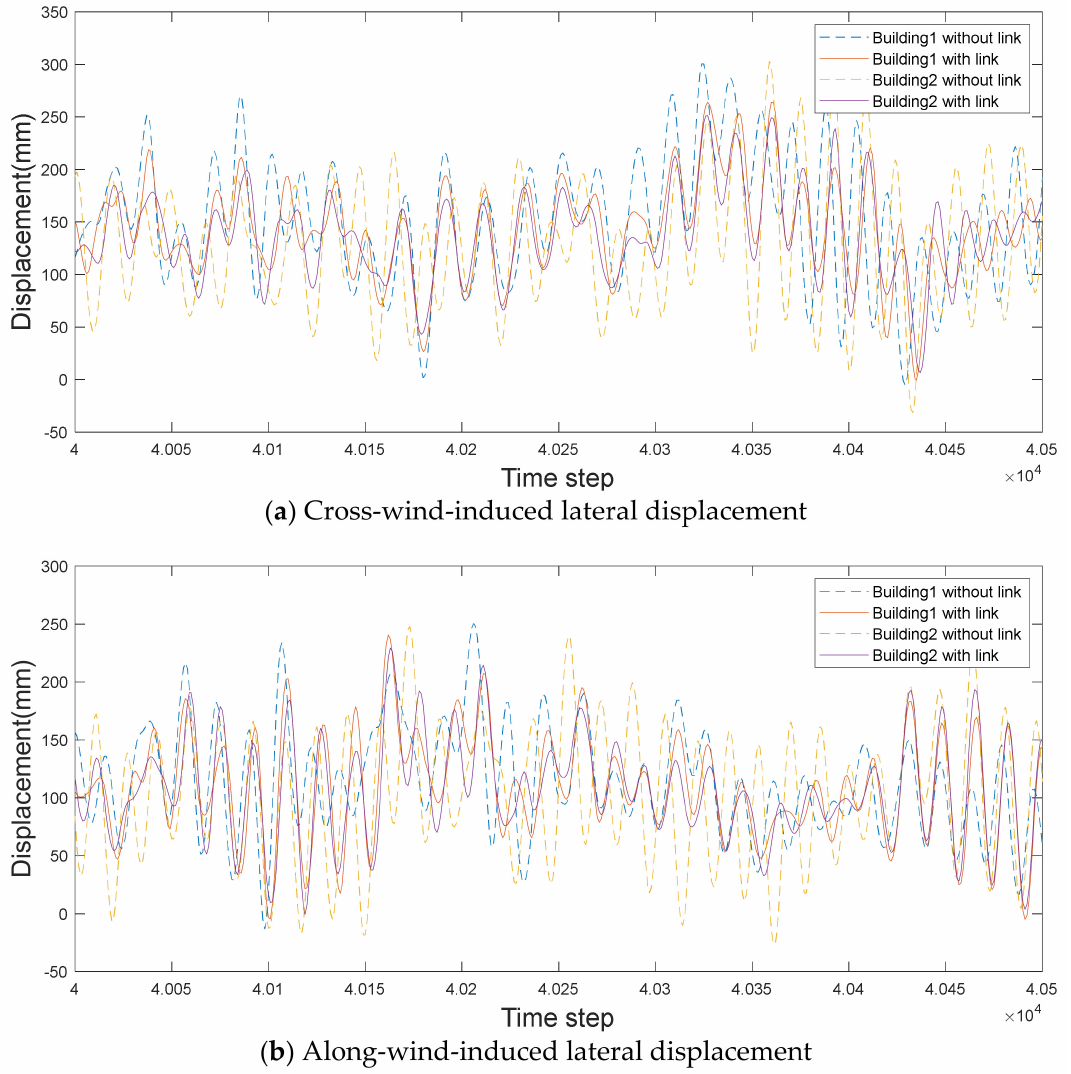
Figure 20. Time histories of wind-induced lateral displacements with a large gap